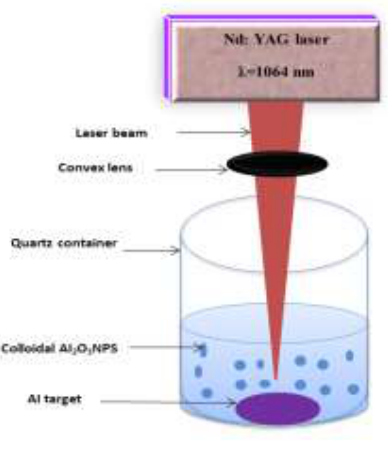
Figure 1: Setup for nanoparticle